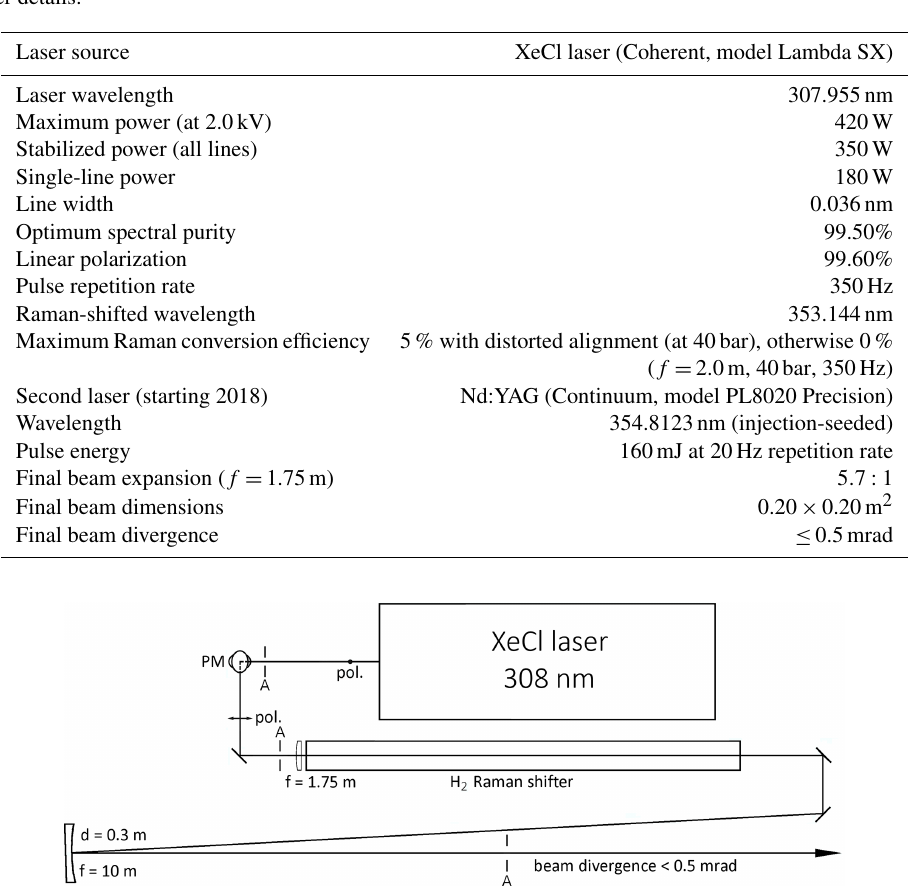
Table 1. Transmitter details.